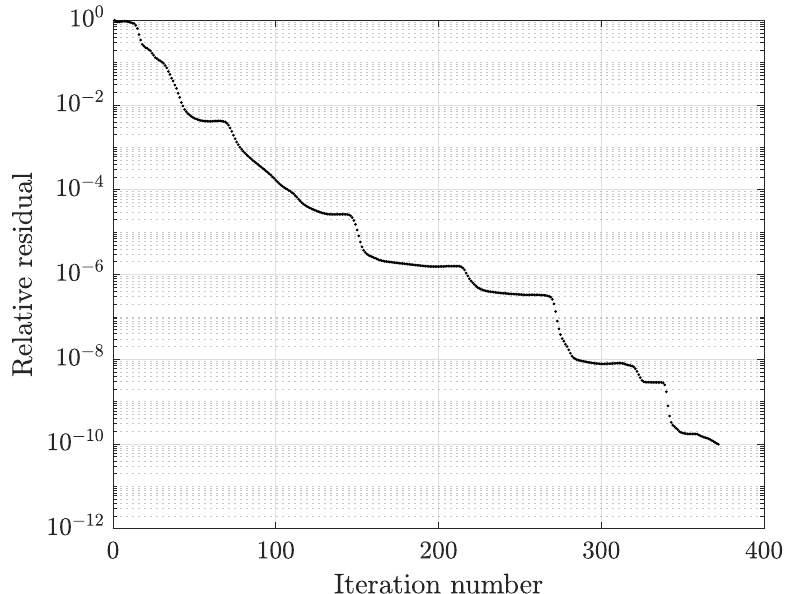
Figure 20. Convergence pattern of the TFQMR solver with SSOR preconditioning at 200 Hz (first ord. 3D FEM with coarsest mesh: 69,702 tets for plate, 1,171,167 tets for